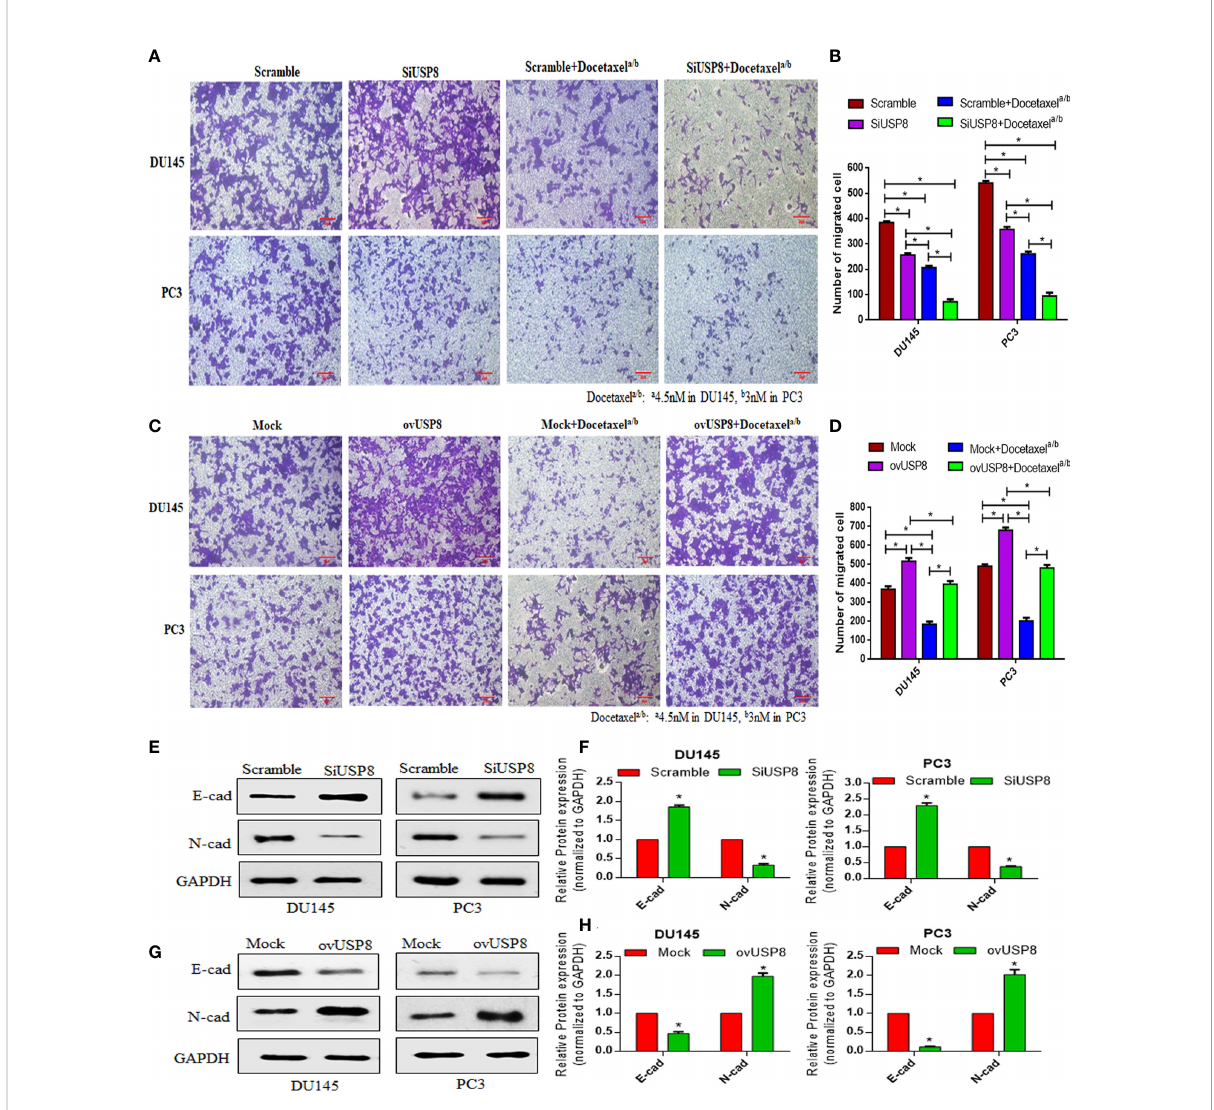
FIGURE 3 Regulation of the number of PCa migrating cells by USP8, and the anti-migrating action of docetaxel in Transwell assay through regulation of EMT- related proteins. (A) Scrambled or USP8-speci fi c siRNA was transfected into PCa cells. Docetaxel was used to treat transfected cells before they were introduced to the Transwell chamber. The migrating cells were treated with 4% paraformaldehyde before being imaged (100×). (B) Mock or pCMV3- USP8-overexpressing vector was transfected into PCa cells. Docetaxel was used to treat transfected cells before they were introduced to the Transwell chamber. The migrating cells were treated with 4% paraformaldehyde before being imaged (100×). (C, D) ImageJ software was used to determine the number of migratory cells, which was shown on a graph. Data are represented as mean ± SD (n = 3, *p < 0.05). The DU145 and PC3 cells were transfected with SiUSP8 (E) and pCMV3-USP8-overexpressing vector (F) for 48 h; total protein was extracted and incubated with antibody (E-cadherin and N-cadherin) after executing Western blotting. GAPDH was utilized as a control in Western blotting. (G, H) The relative gray value was measured using ImageJ software and plotted on a bar diagram by GraphPad prism. The data were standardized using GAPDH as a loading control and given as mean ± SD (n = 3, * p <